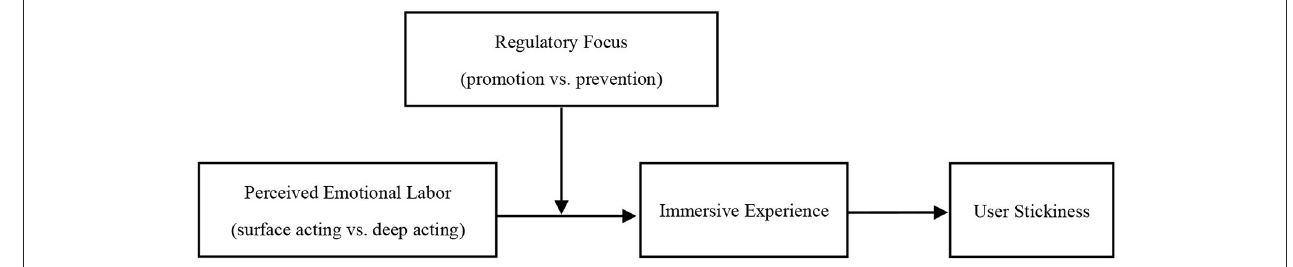
FIGURE 1 | Conceptual